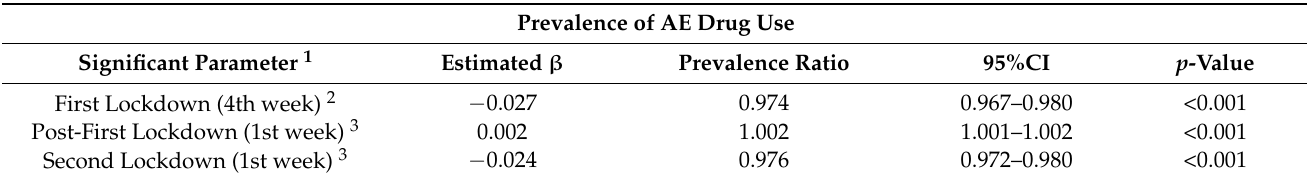
Table A1. Time series analysis of anti-seizure medication (ASM) prevalence considering a 60-day grace period between different periods: Pre-Lockdown, First Lockdown, Post-First Lockdown and Second